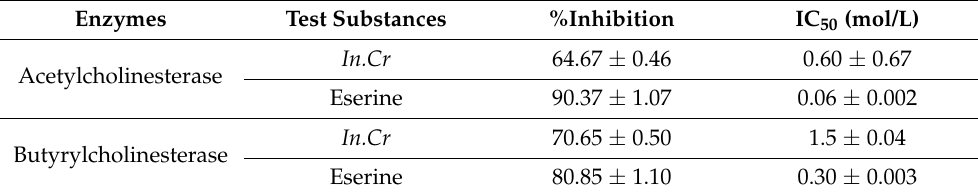
Table 3. Inhibitory profile of In.Cr oncholinesterases’ enzyme actions. Enzymes Test Substances %Inhibition IC 50 (mol/L) In.Cr Acetylcholinesterase In.Cr